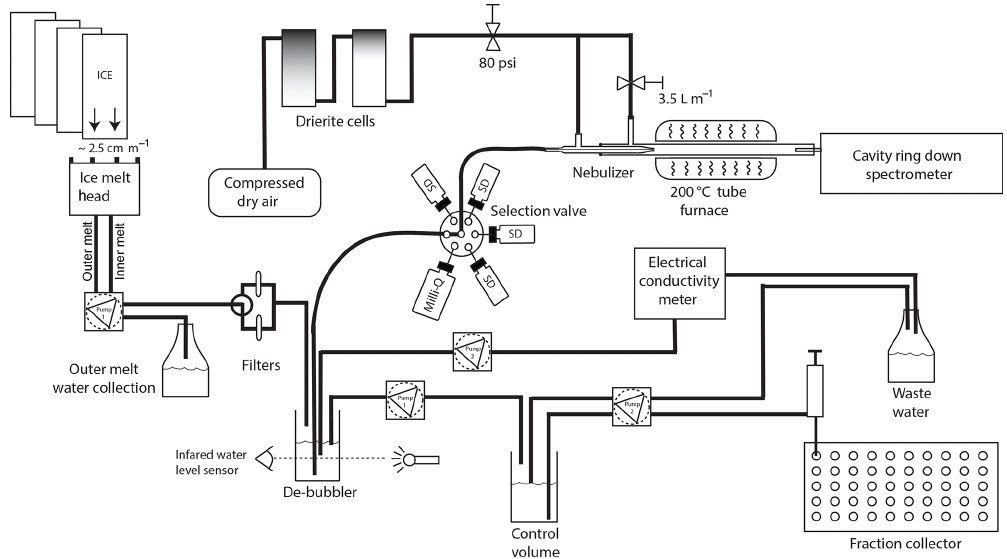
Figure 1. The INSTAAR CRDS-CFA system, showing sample flow from the ice melt head through the filter block and debubbler and onto the Valco stream selection valve, nebulizer, furnace, and Picarro L-2130-i CRDS instrument.